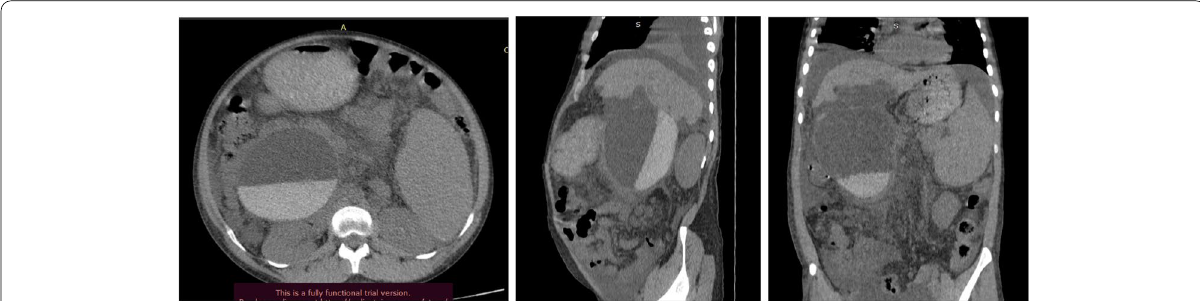
Fig. 2 Abdominal CT scan showing a large intra-abdominal cystic mass at the common bile duct classified as TODANI type IVA and a dysmorphic liver of cirrhotic appearance